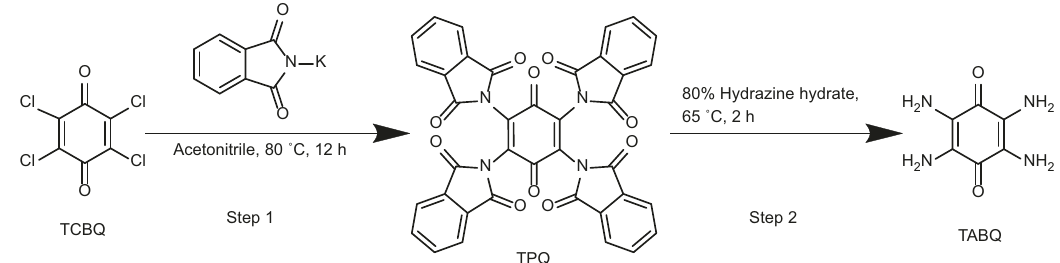
Fig. 6 Synthetic routes of TABQ. TABQ was obtained by a two-step synthesis with